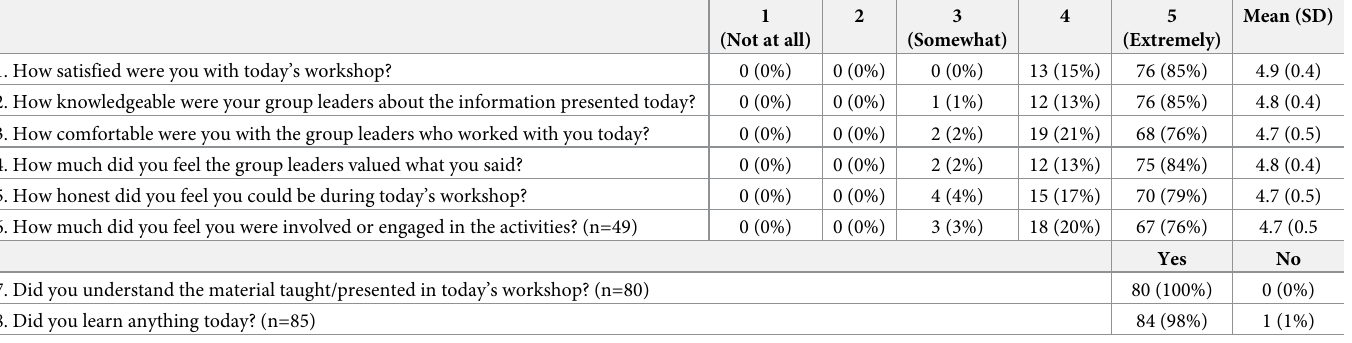
Table 4. Intervention acceptability among adolescent girls and young women and female caregivers randomized to the IMARA-SA intervention, aggregating sur- veys across intervention days (n = 89 evaluations).